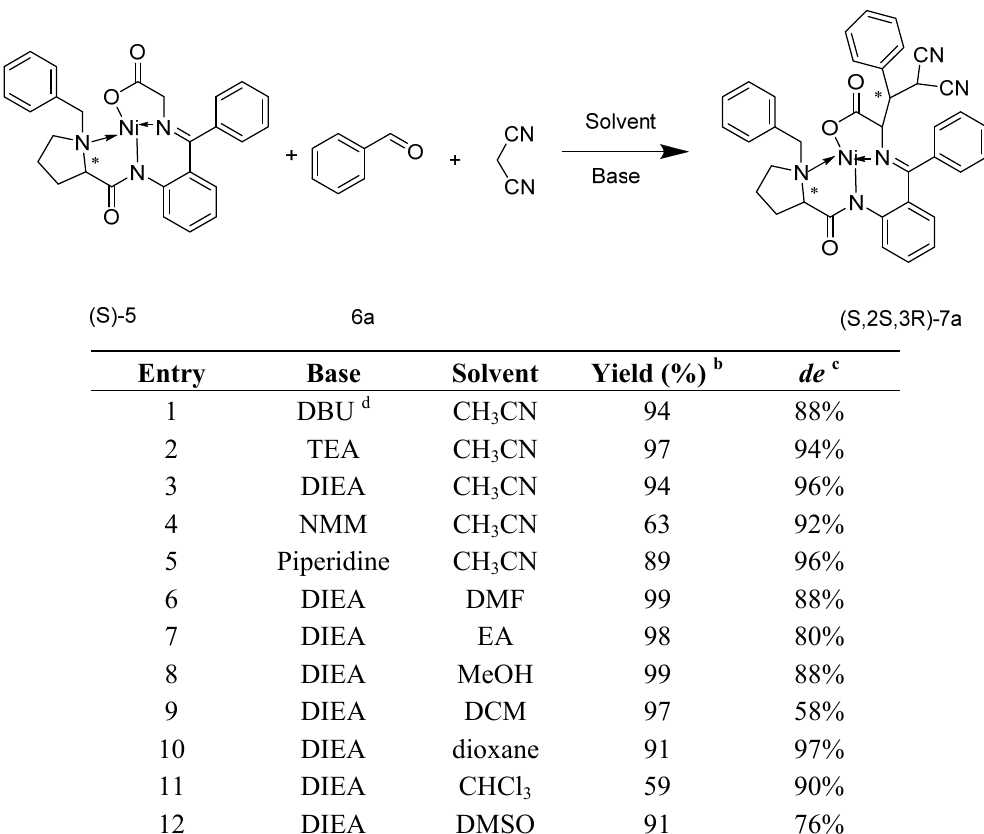
Table 1. Optimization of the reaction conditions a